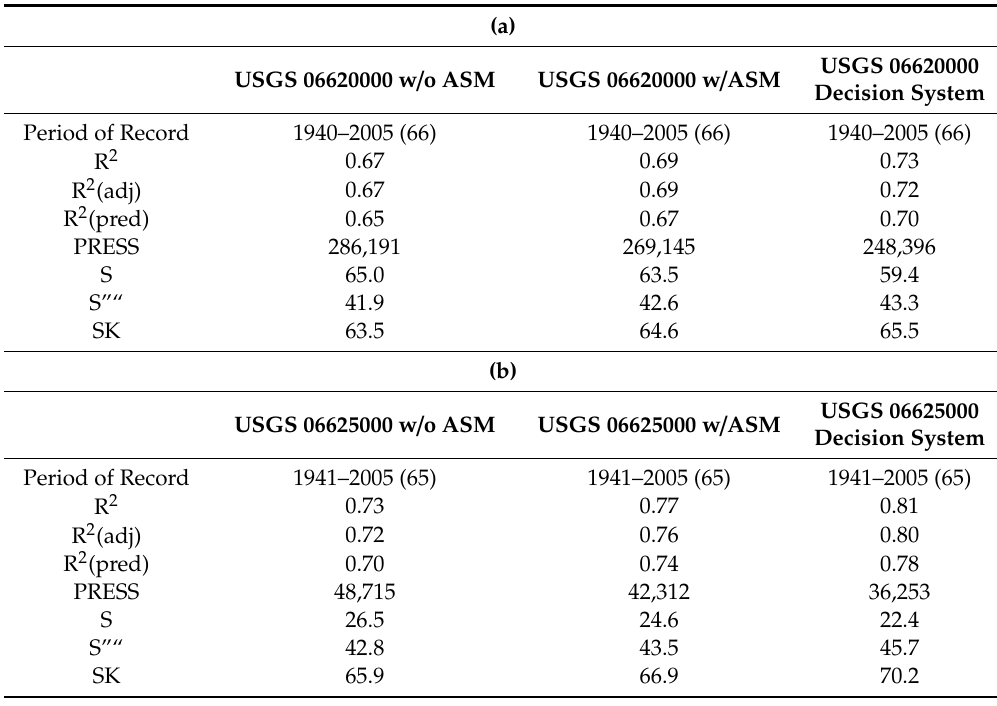
Table 1. Prediction and validation statistics for ( a ) USGS 06620000 ( b ) USGS